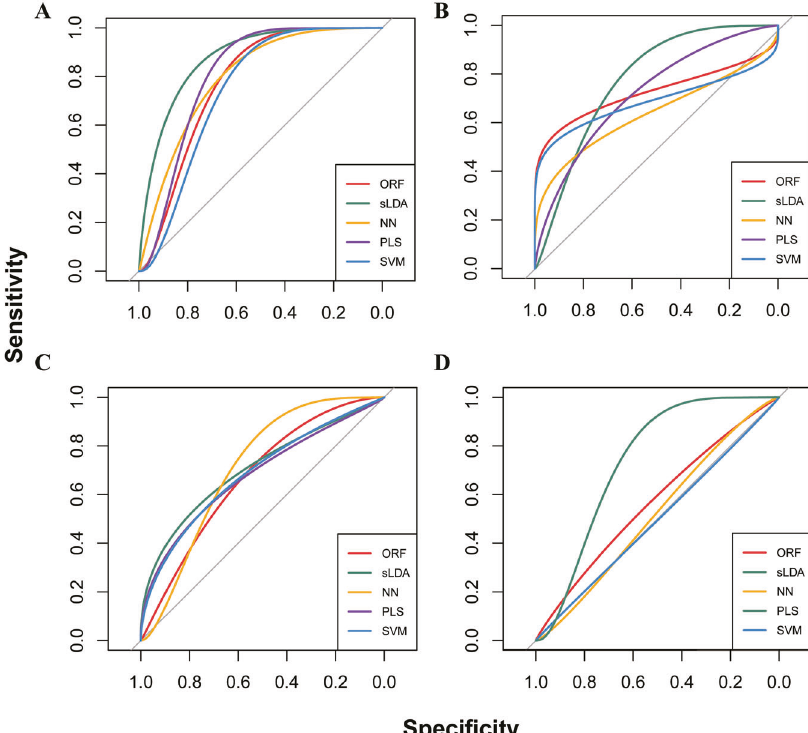
Fig. 3 ROC curve for prediction for the immuno-behaviourally de fi ned responding group. The classi fi ers included the Oblique Random Forest (ORF) model, Partial Least Squares (PLS) model, Support Vector Machine (SVM) model, sparse Linear Discriminant Analysis (sLDA) model and Neural Networks (NN) model. Based on the immuno-behavioural covariation plane, the models were trained to predict the response to bumetanide for the children with ASD. As described in the main text, the models were trained using the Discovery Set, and tested using the Validation Set. The performances of the classi fi cation accuracy in the testing data set were reported in this fi gure. A Models with the cytokine levels at the baseline for predicting patients with ASD in the best responding group. B Models without the cytokine levels at the baseline for predicting patients with ASD in the best responding group. C Models with the cytokine levels at the baseline for predicting patients with ASD in the least responding group. D Models without the cytokine levels at the baseline for predicting patients with ASD in the least responding